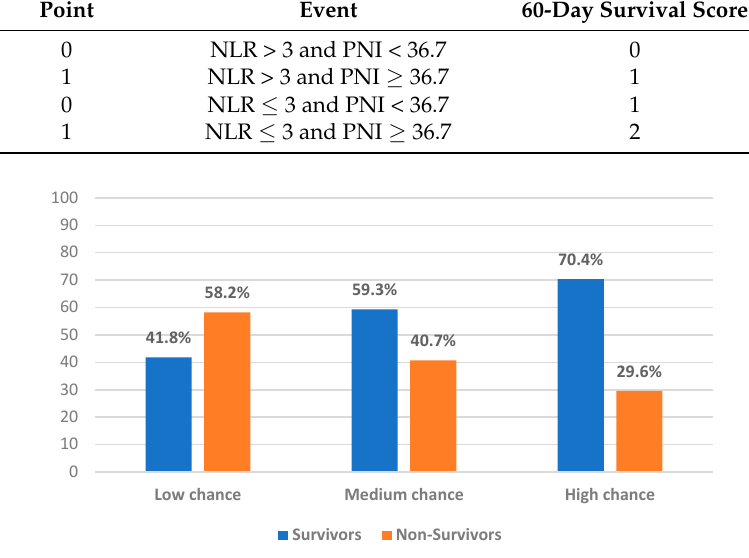
Figure 2. Distribution of 60-day survival score in the study